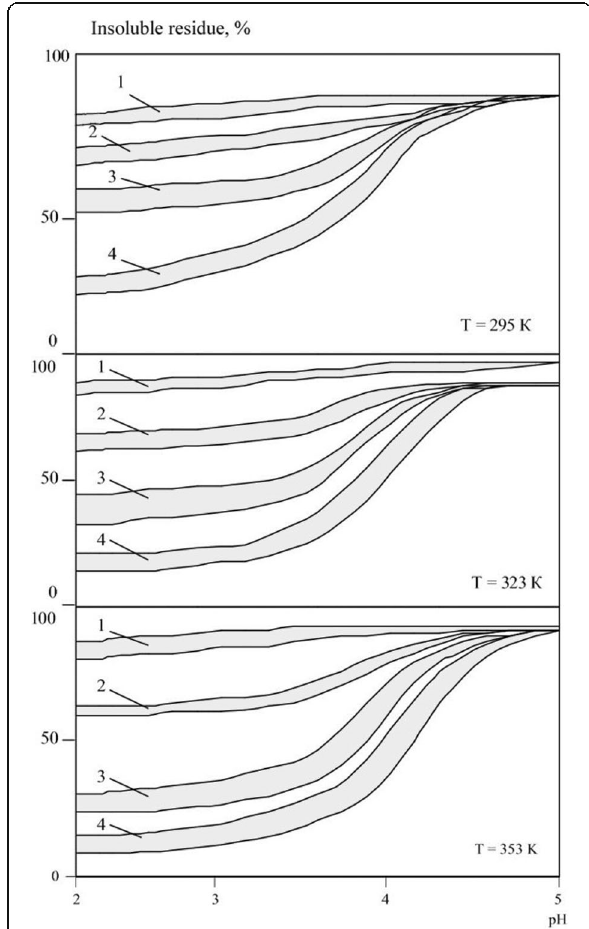
Fig. 2 Insoluble residues ratios areas for nanopowders of carbides of silicon, zirconium, titanium, vanadium, chromium, molybdenum, and tungsten in electrolytes solutions of different acidity depending on